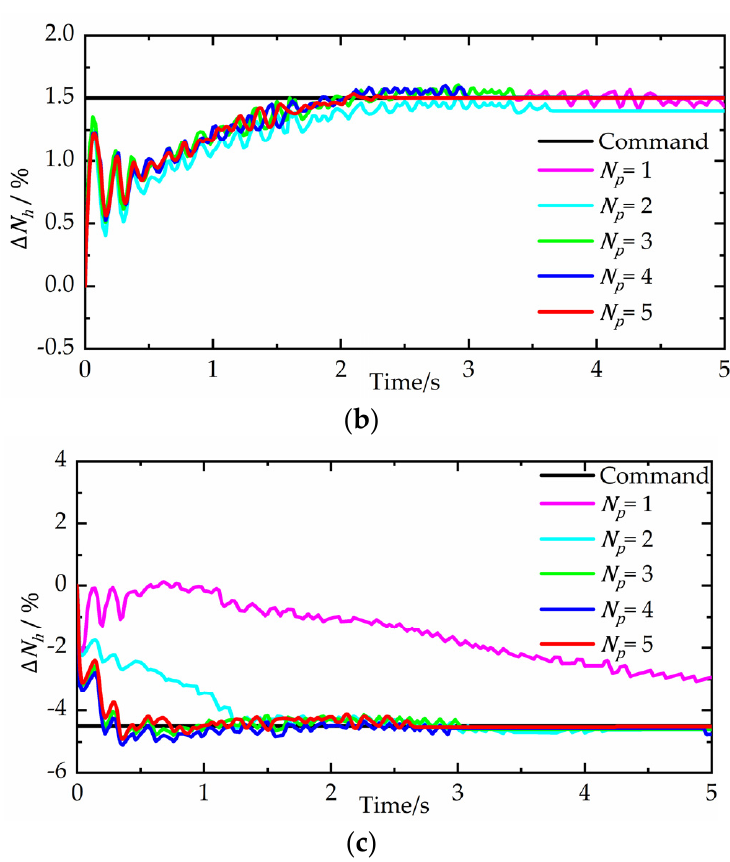
Figure 6. Step responses at different prediction horizons. ( a ) Variation of speed of high pressure rotor. ( b ) Variation of speed of low pressure rotor. ( c ) Variation of total sound pressure level of jet noise.